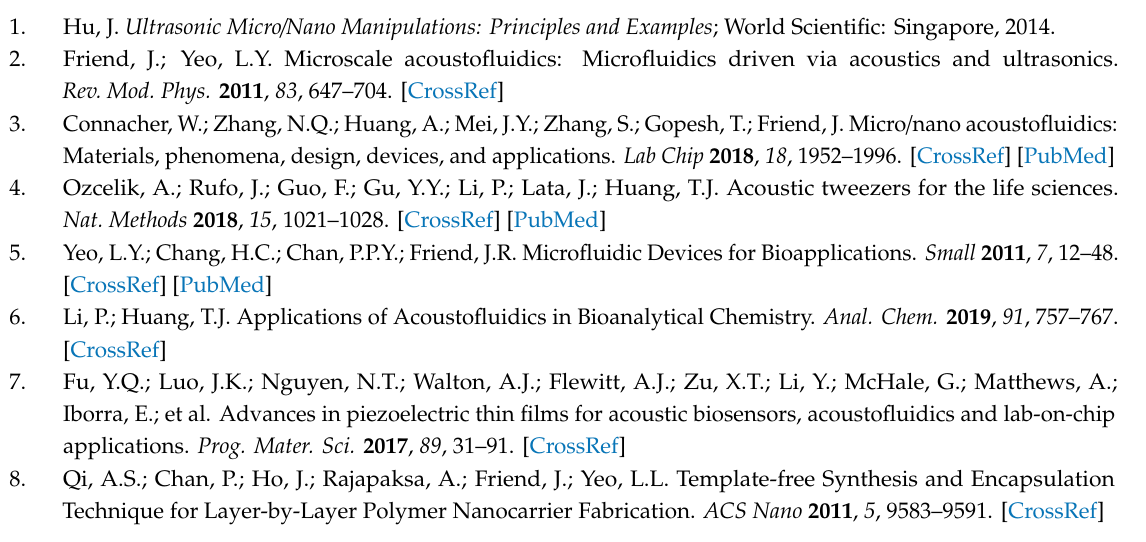
Figure S3 (a) Computed acoustic radiation force field for yeast cells in the ultrasonic probe-droplet-substrate system under the mesh constitution for the PM. (b) Computed acoustic radiation force field for SiNPs in the ultrasonic probe-droplet-substrate system under the mesh constitution for the PM. Figure S4 (a) Computed acoustic radiation force field for yeast cells in the droplet-ultrasonic substrate system under the mesh constitution for the PM. (b) Computed acoustic radiation force field for AgNPs in the droplet-ultrasonic substrate system under the mesh constitution for the